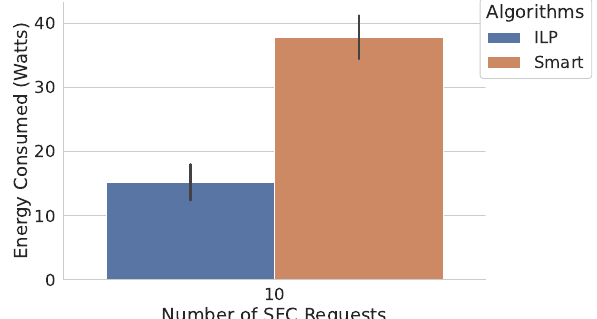
Figure 4. Consumed energy in edge nodes.